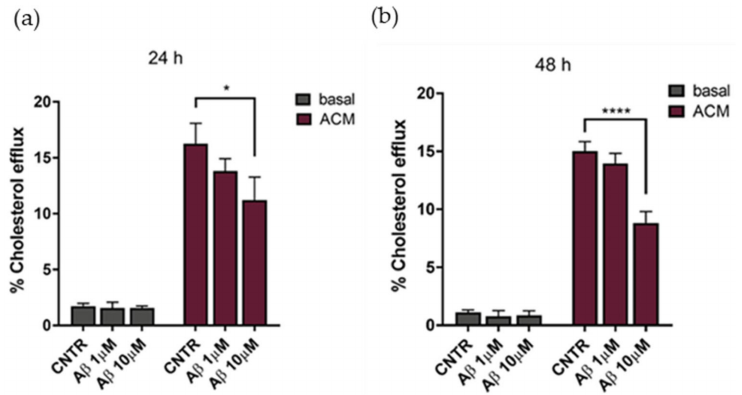
Figure 5. Evaluation of cholesterol efflux from astrocytes in AD-like conditions, in the presence of ACM as acceptor of cholesterol. The cholesterol efflux was measured using the Cholesterol Efflux Assay kit, after treatment with A β 1-42 oligomers (1 µ M or 10 µ M) for 24 ( a ) or 48 ( b ) h. The fluorescence of supernatant and of cellular lysates was measured by spectrofluorometer. Data are expressed as the mean of the samples in triplicate ± SEM; * p < 0.05; **** p < 0.0001 (2way ANOVA).